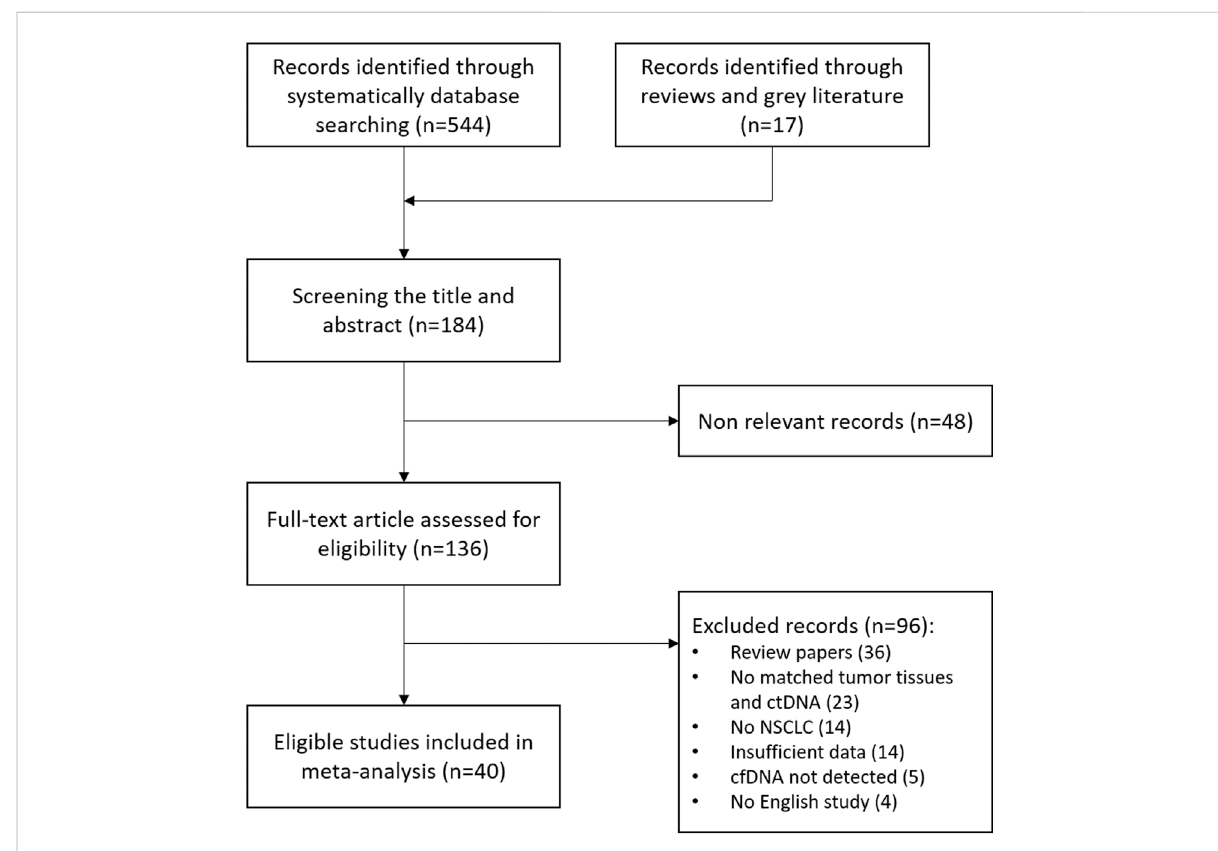
FIGURE 1 Flow diagram of literature screening and study